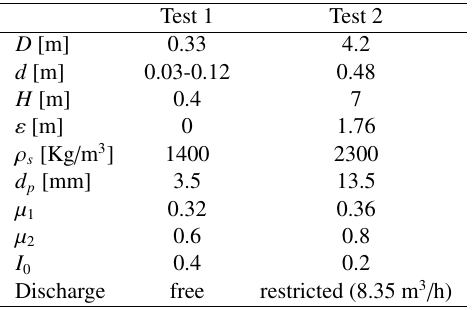
Table 1. Physical and dimensional parameters for the 3D silos